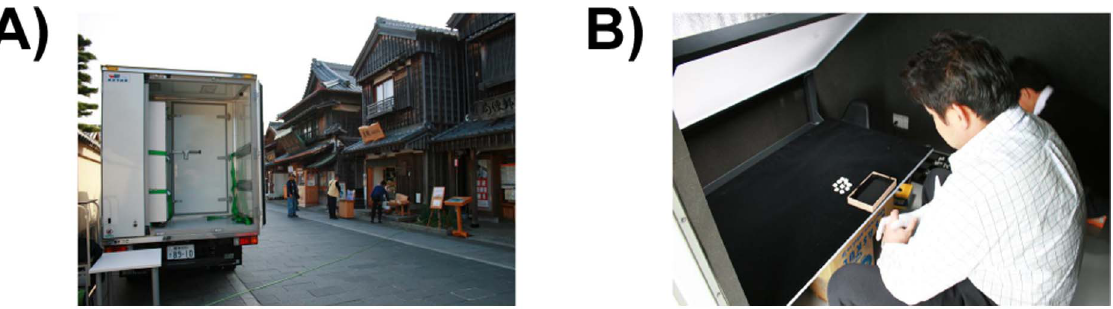
Figure 3. Photographs of the experimental conditions. (A) A snapshot of ‘‘Mobile-Labo’’ truck. The experimental space is beyond the inner door. For this photograph, we parked on a street in front of the office in the courtyard of the laboratory and conducted the experiment. (B) Experimental setting for the experts. The person sitting in front is the participant. The white board above the black desktop is the diffuser. The participant is asked to sort the pearls according to a subjective criterion in the small box. The experimenter received the box and recorded the order.